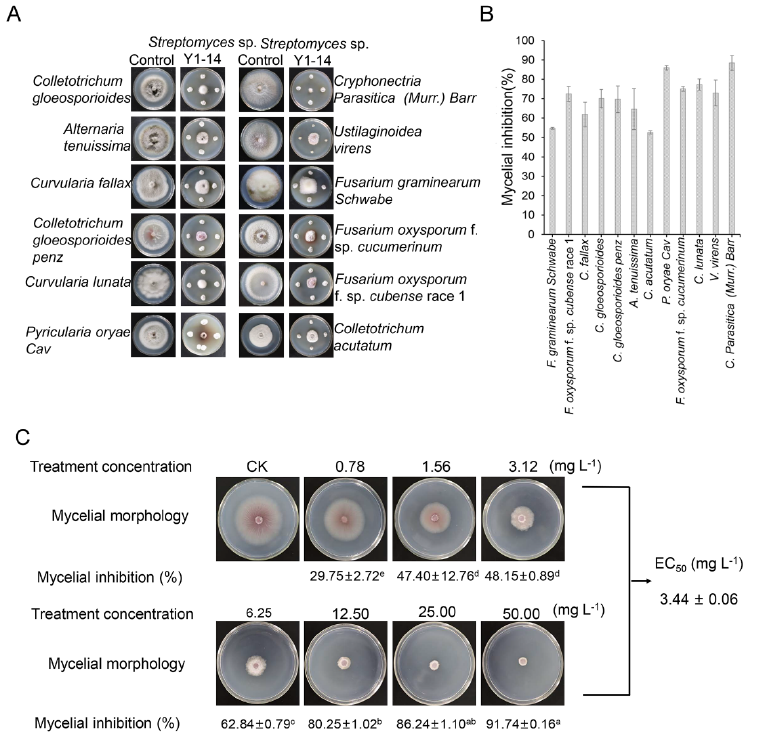
Figure 2. ( A ) A broad-spectrum antifungal activity of Streptomyces sp. Y1-14 against the selected twelve phytopathogenic fungi. ( B ) The mycelial inhibition (%) of Foc TR4 after treatment with